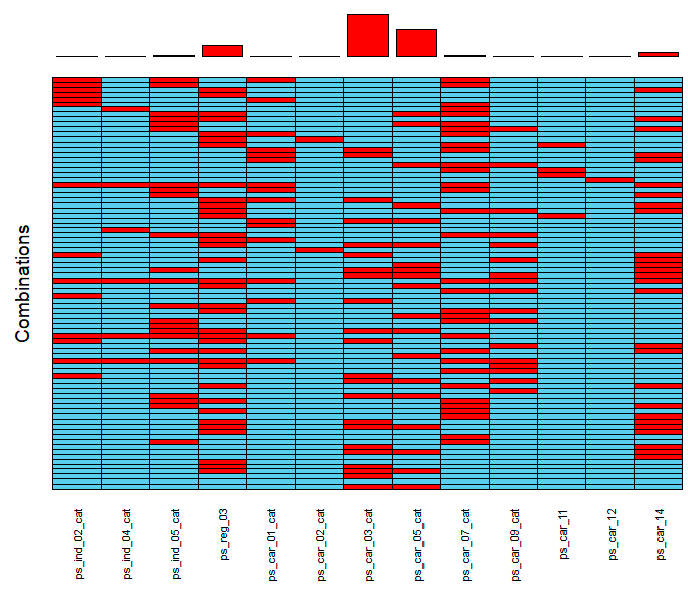
Figure 7. Missing values in our data.